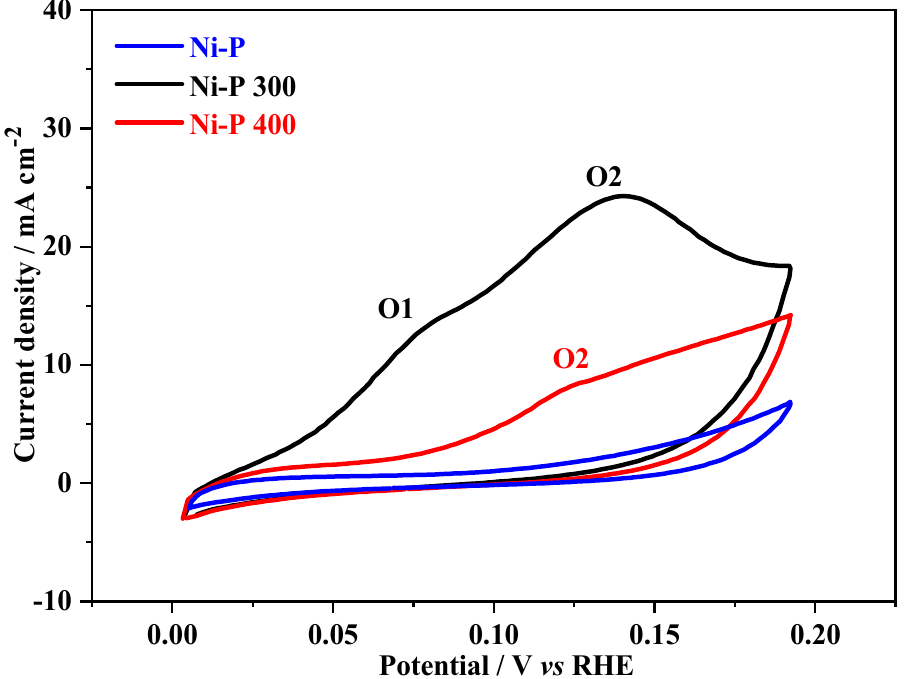
Figure 7. Electrochemical CV curves of the Ni-P catalysts recorded between the potential of 0 and 0.2 V vs. RHE.